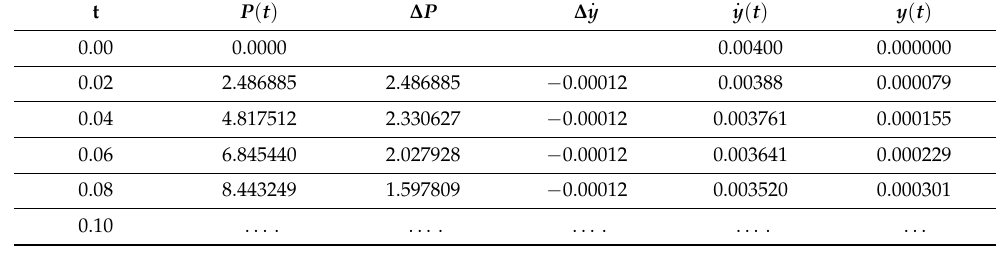
Table 3. Newmark Numerical Method.